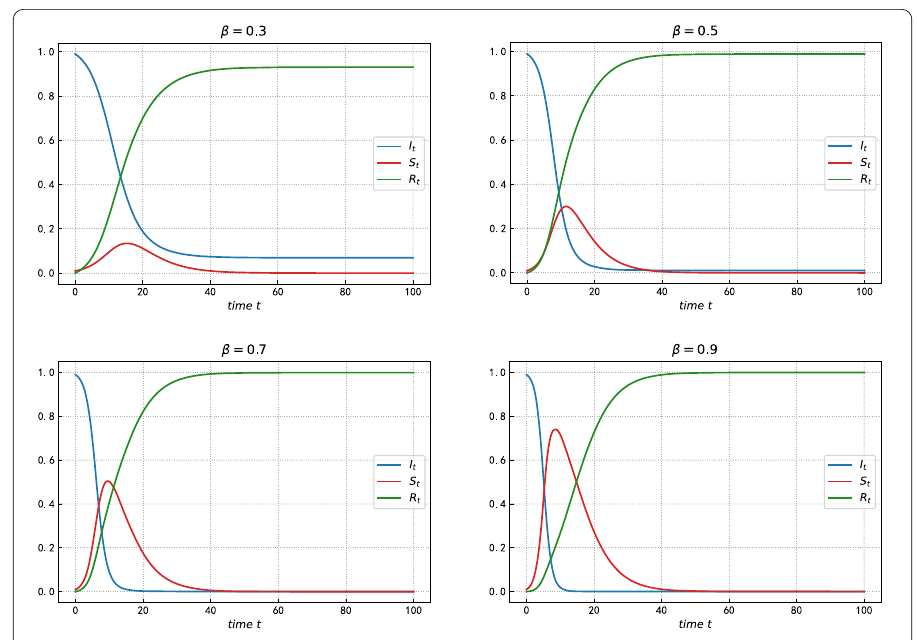
Figure 4 The α -paths of I α t , S α t , and R α t with β = 0.3,0.5,0.7, and